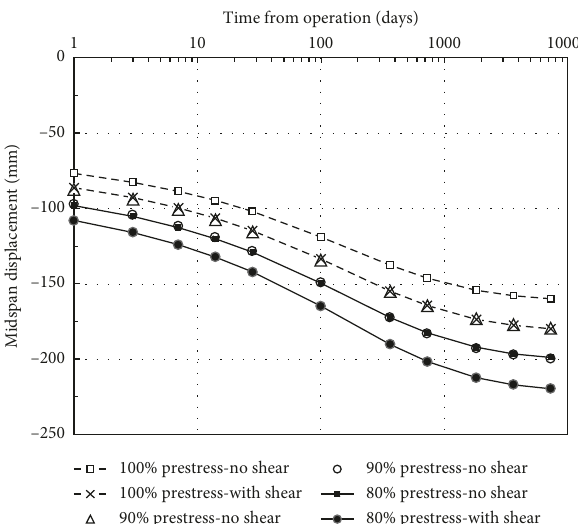
Figure 6: Deflection of midspan with different degrees of prestress.